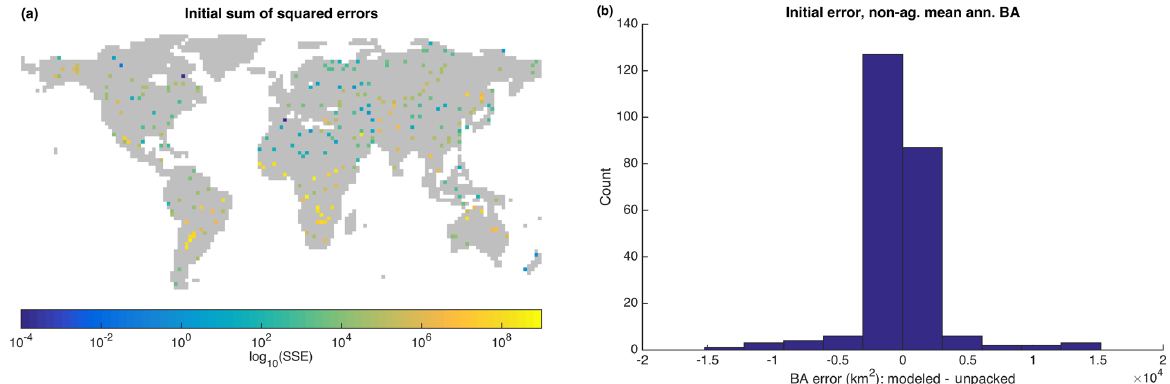
Figure A3. Summary of performance of Optimization 1 initial guess in grid cells chosen for optimization with regard to non-agricultural burning. (a) Map of sum of squared errors. (b) Histogram of error in mean annual burned